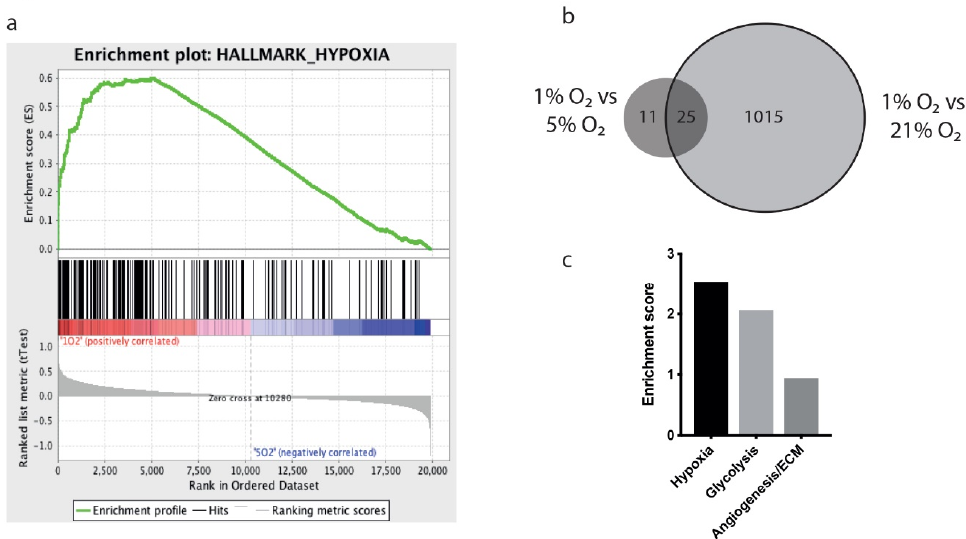
Figure 1. Whole transcriptome analysis of Ge835, Ge898, Ge904, LN18, and LN229 glioblastoma multiforme (GBM) cell lines cultured under hypoxia (1% O 2 ), physioxia (5% O 2 ), or hyperoxia